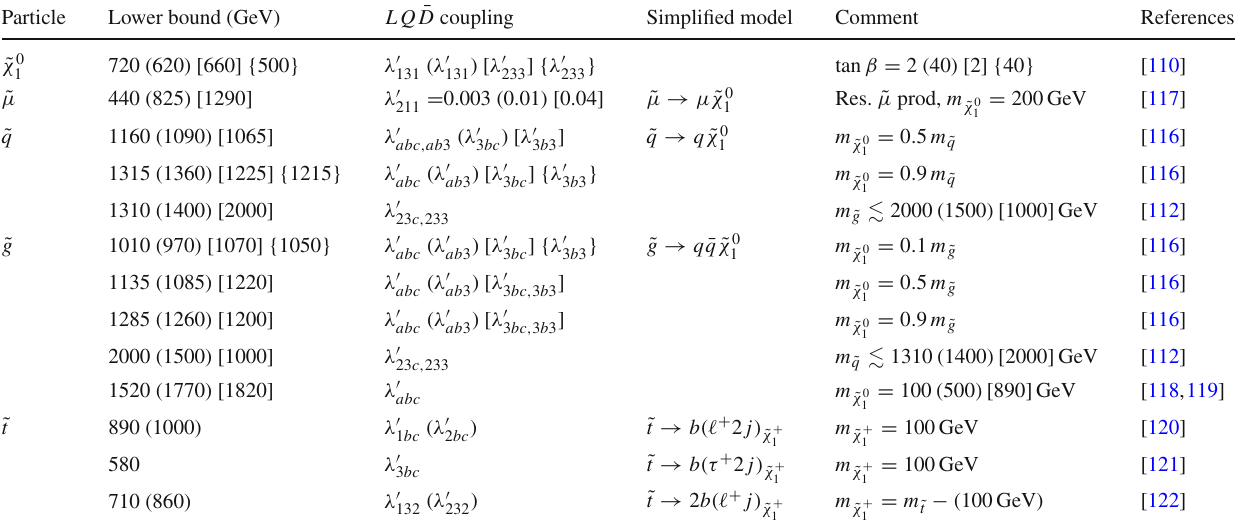
Table6 BestlimitsinRPVsearchesusingsimplifiedmodelsand LQ ¯ D operators.Here a , b , c ∈ { 1 , 2 } .Thepair-producedsupersymmetricpar- ticles are assumed to decay directly to the neutralino LSP. The bounds are only estimates, as they have been read off the relevant plots. The L i Q j ¯ D k . We have included the analysis of a scalar top decaying via a charginoandnottheneutralinoLSPinthelastline,sinceitissimilar.The